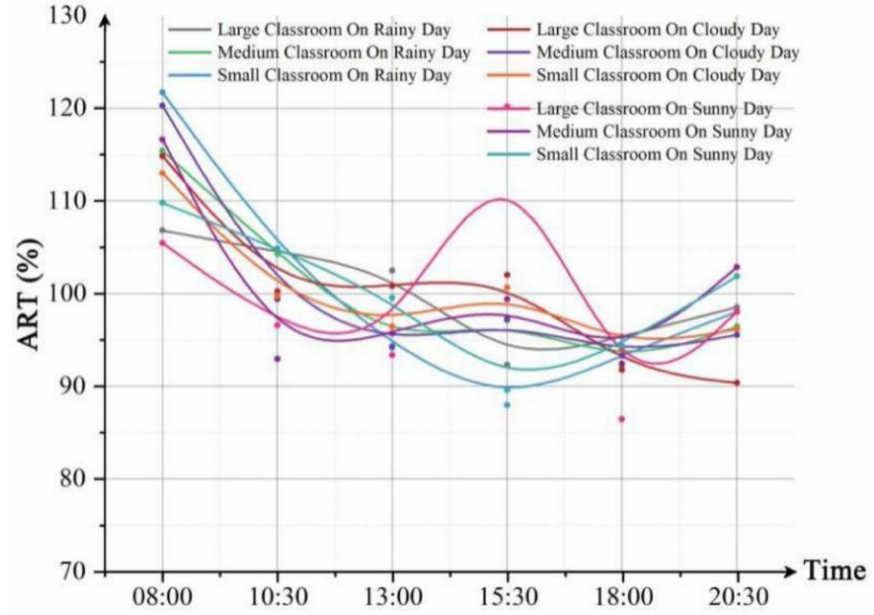
Figure 19. The ART of the learning efficiency test in the classroom-types under different weather conditions throughout the